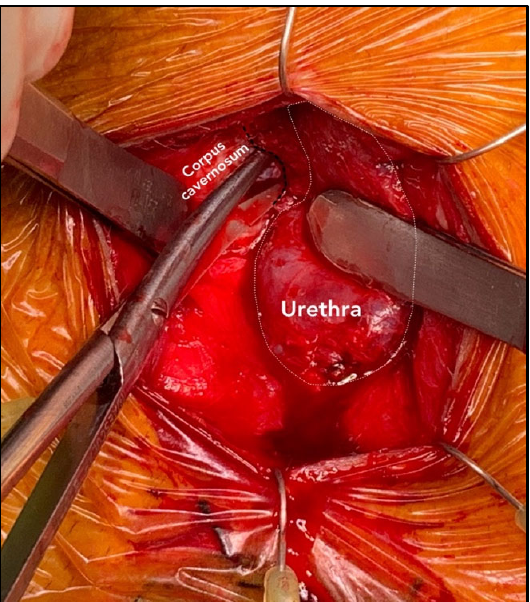
Figure 1. Left incision of the tunica albuginea of the corpora cavernosa 5 mm off the posterior attachment of the urethra to the corpora cavernosa.